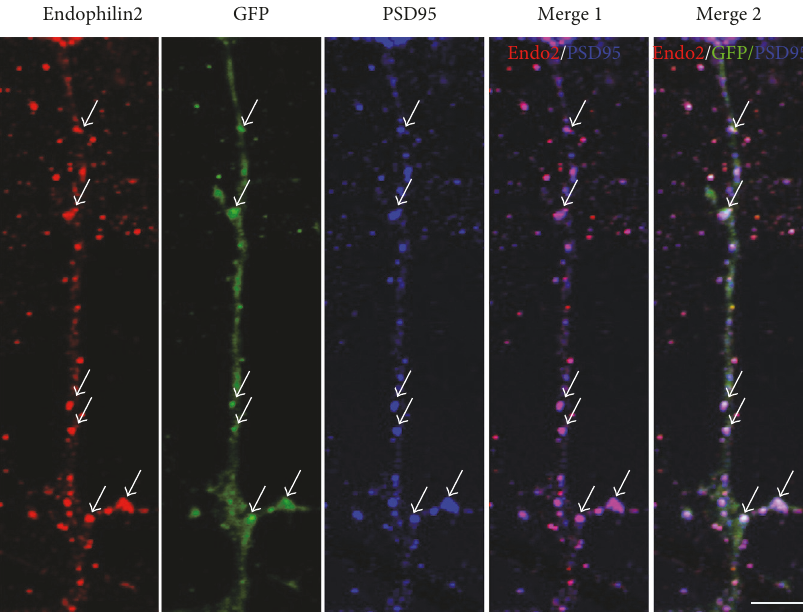
Figure 4: Endophilin2 localizes to postsynaptic sites in mature neurons. DIV14 hippocampal neurons expressing the green fl uorescent protein (GFP) as a volume marker were immunostained with antibodies to endophilin2 (red) and PSD95 (blue). Merge 1 shows the endophilin2 colocalization with PSD95 and merge 2 the three proteins. Arrows indicate the colocalization part as indicated. The images shown are representative confocal microscopy images. Scale bar, 5 μ